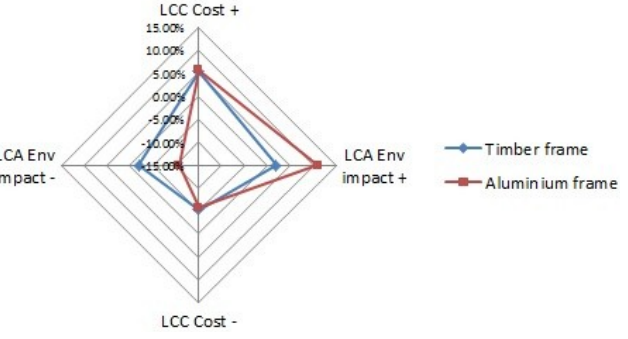
Figure 3. Sensitivity analysis: economic and environmental impacts.